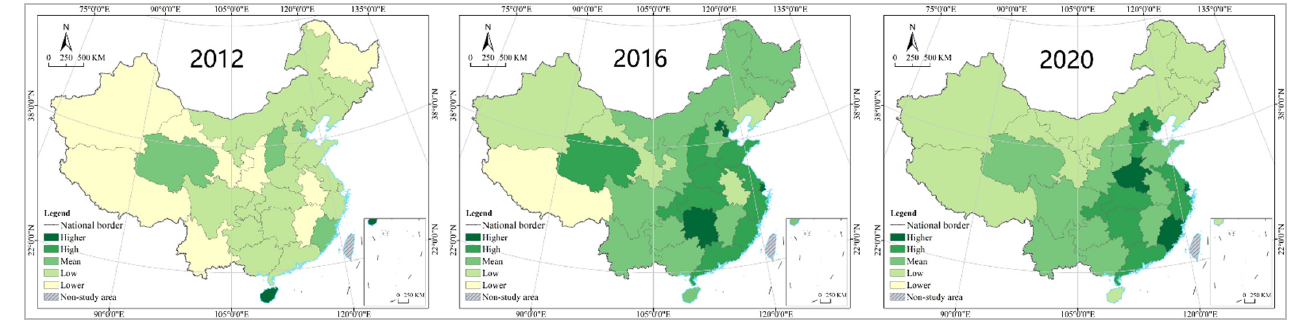
Figure 12. Analysis of spatial clustering of per area added value.